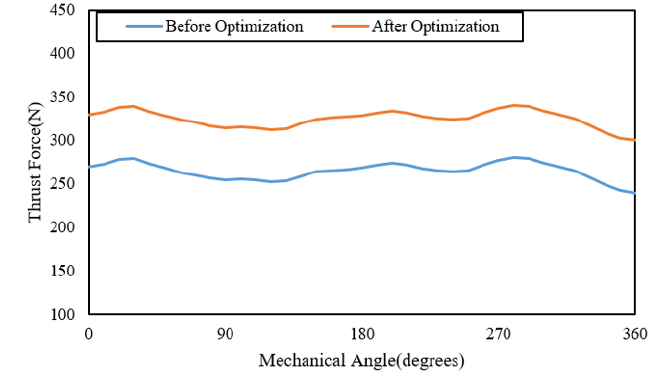
Figure 20. Comparison between initial and optimized